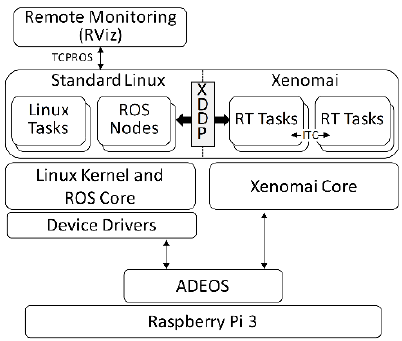
Figure 10. Integration of ROS to Xenomai real-time tasks.